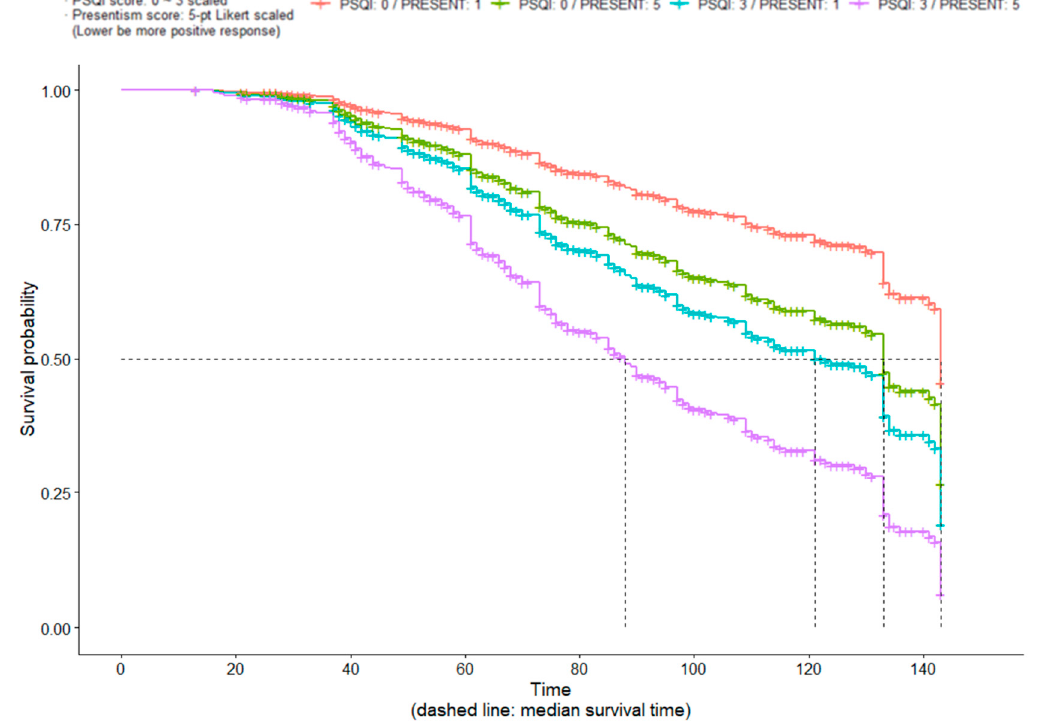
Figure 2. Survival curves based on career duration of nurses according to PSQI and presenteeism. A PSQI score of 0 was the minimum value considered (red, green), whereas 3 was the maximum (purple, blue). A presenteeism (PRESENT) score of 1 was the minimum (red, blue), whereas 5 was the maximum (green, purple).